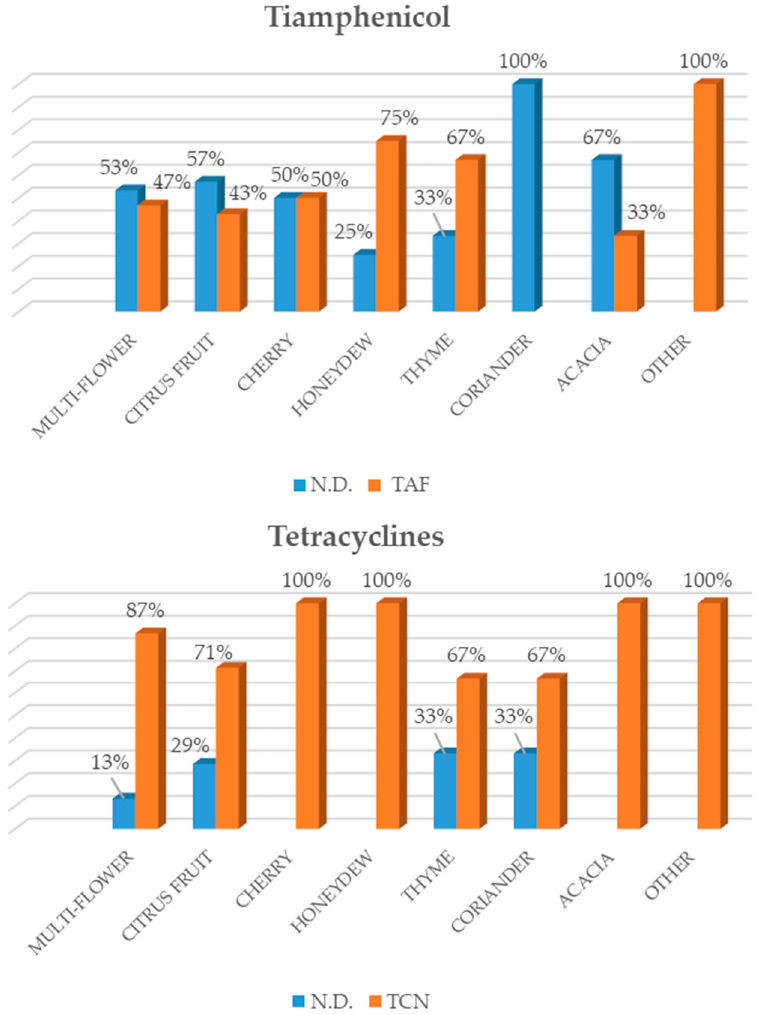
Figure 1. Percentage of positive samples and samples with a quantity of antibiotic undetectable by the instrument (N.D.), distinguished according to the antibiotic type. Figure 1 presents the second group of honey, consisting of forty-two samples produced in the Apulia region during 2017.